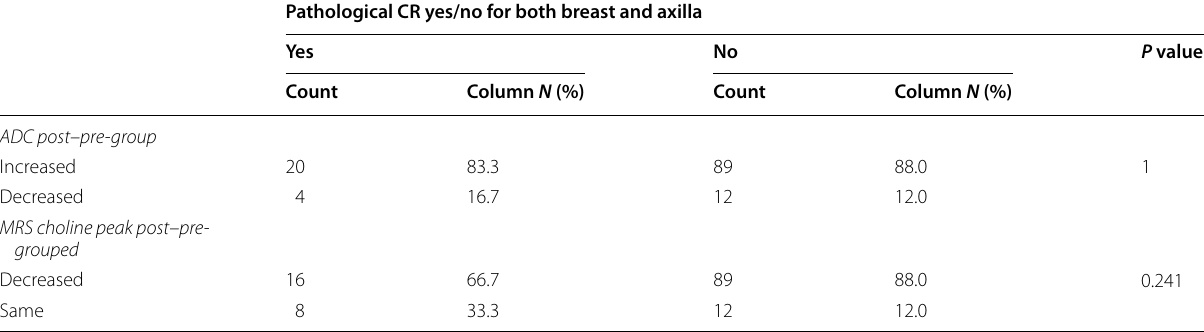
Table 2 Cross-tabulation representing relation between increase post-NAC ADC value and decrease post-NAC MRS choline peak to predict pathological complete